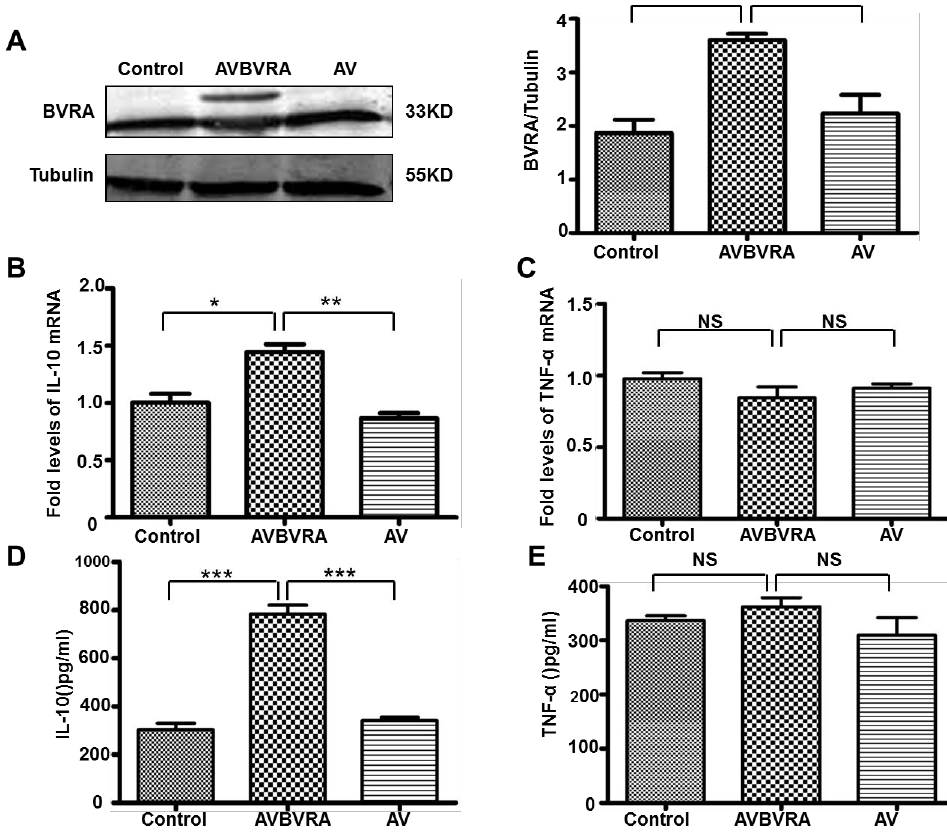
Figure 3. BVRA over-expressed macrophages showed increased IL-10